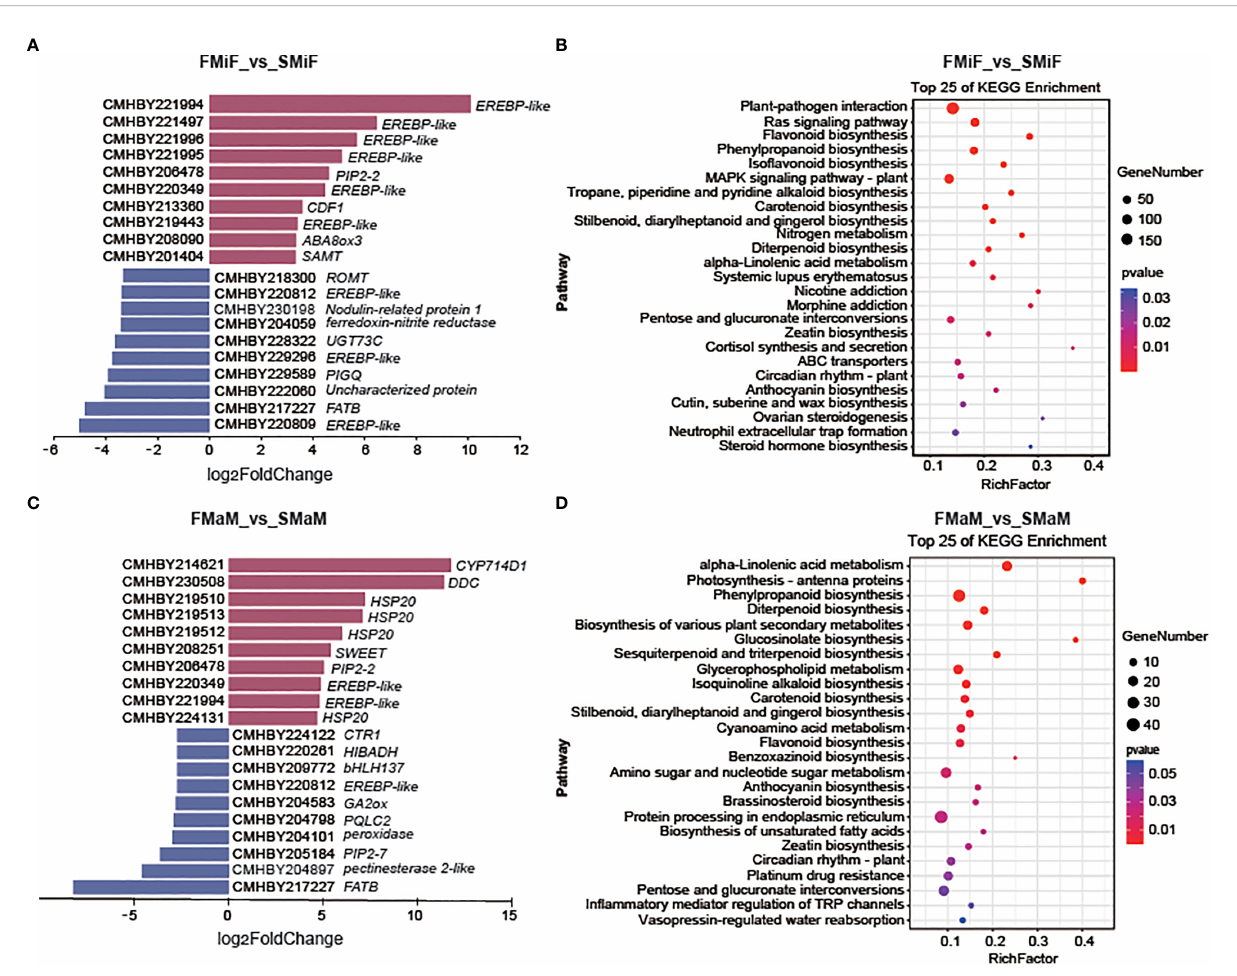
FIGURE 2 Transcriptome analysis offemale and male fl owers in different seasons. (A) Top 10 upregulated and downregulated DEGs between fi rst and secondary female fl owers. (B) KEGG enrichment of DEGs of FMiF_vs_SMiF. (C) Top 10 upregulated DEGs and downregulated DEGs between fi rst and secondary male fl owers. (D) KEGG enrichment of DEGs of FMaM_vs_SMaM. CDF1, cycling doffactors; ABA8, abscisic acid 8 ’ -hydroxylase; ROMT, trans-resveratrol di-O-methyltransferase; SAMT, salicylate 1-O-methyltransferase; UGT73C, UDP-glucosyl transferase; PIGQ, phosphatidylinositol N-acetylglucosaminyltransferase subunit Q; FATB, fatty acyl-ACP thioesterase B; CYP714D1, gibberellin 16alpha,17-epoxidase; SWEET, solute carrier family 50 (sugar transporter); CTR1, solute carrier family 31; HIBADH, 3-hydroxyisobutyrate dehydrogenase; GA2ox, gibberellin 2beta-dioxygenase; PQLC2, solute carrier family 66; FATB, fatty acyl-ACP thioesterase